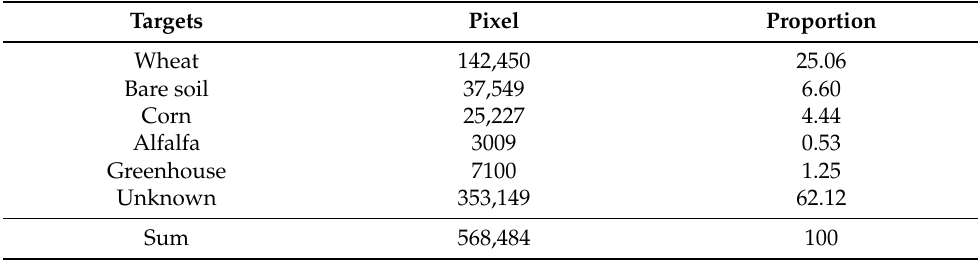
Figure 4. Images of the study area. ( a ) Optical image from Google Earth. ( b ) Radar image. ( c ) Ground truth. Table 2. Crop information of the study